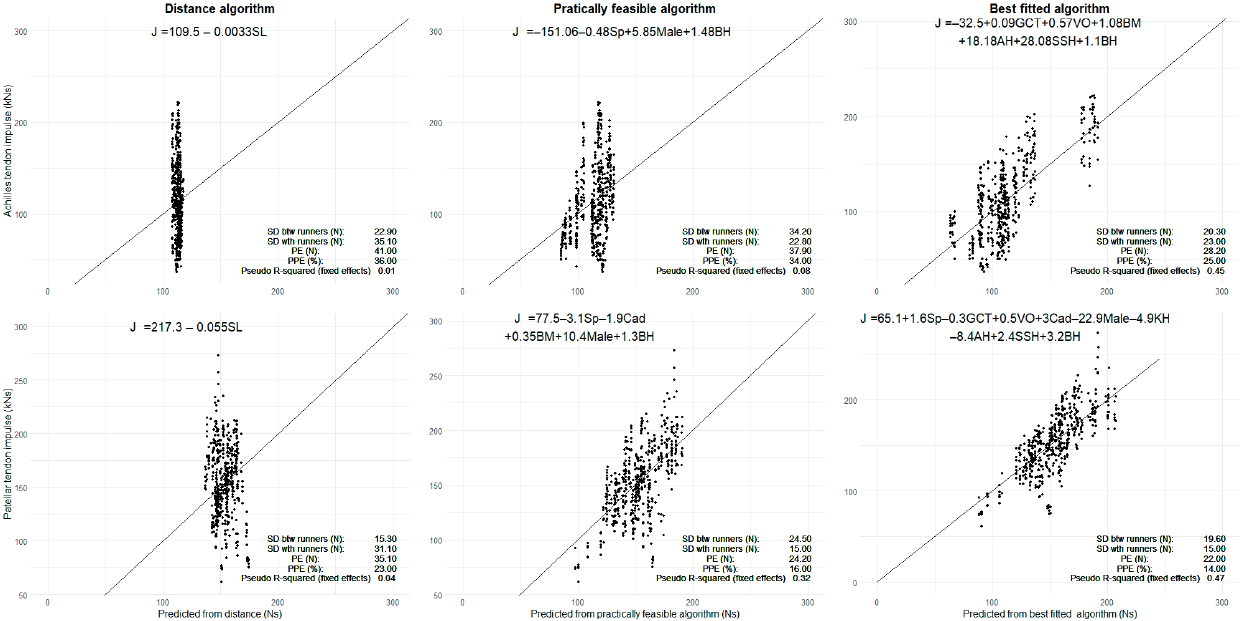
Figure 4. The prediction of impulse forces using the different algorithms. The black diagonal line is the perfectly fitted line. The black dots are the AnyBody-estimated forces on the y -axis and predicted forces on the x -axis. SL: Stride length; Sp: Speed; BH: Body height; BW: Bodyweight; KH: Knee height; AH: Ankle height; SSH: Shoe sole height; Cad: Cadence.